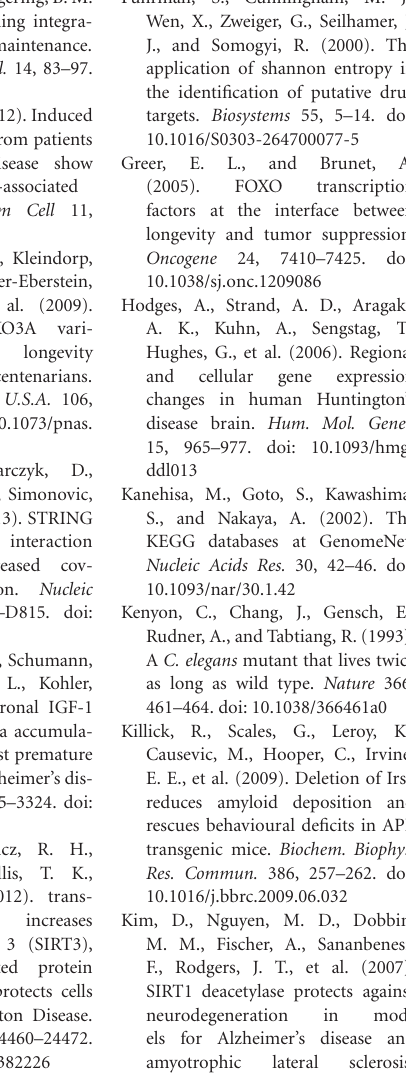
models (striatum) of HD. Biological content is inferred from enrichment in KEGG pathways ( P < 0 . 001). Figure S4 | Heat-map representing the biological content for low to high entropy genes in the FOXO3-interaction network and across seven human HD (post-mortem caudate nucleus and cortex, blood samples from pre-and post-symptomatic HD subjects, iPS cells) datasets. Biological content is inferred from enrichment in KEGG pathways ( P < 0 . 001). Figure S5 | Heat-map representing the biological content for low to high entropy genes in the FOXO3-interaction network and across seven mouse models of HD (striatum) and seven human HD (post-mortem caudate nucleus and cortex, blood samples from pre-and post-symptomatic HD subjects, iPS cells) datasets. Biological content is inferred from enrichment in KEGG pathways ( P < 0 . 001). Figure S6 | Graph showing the distribution of entropy values in a KEGG pathway (here “Long-term potentiation”) that is specifically enriched in genes with high entropy values (see Figure